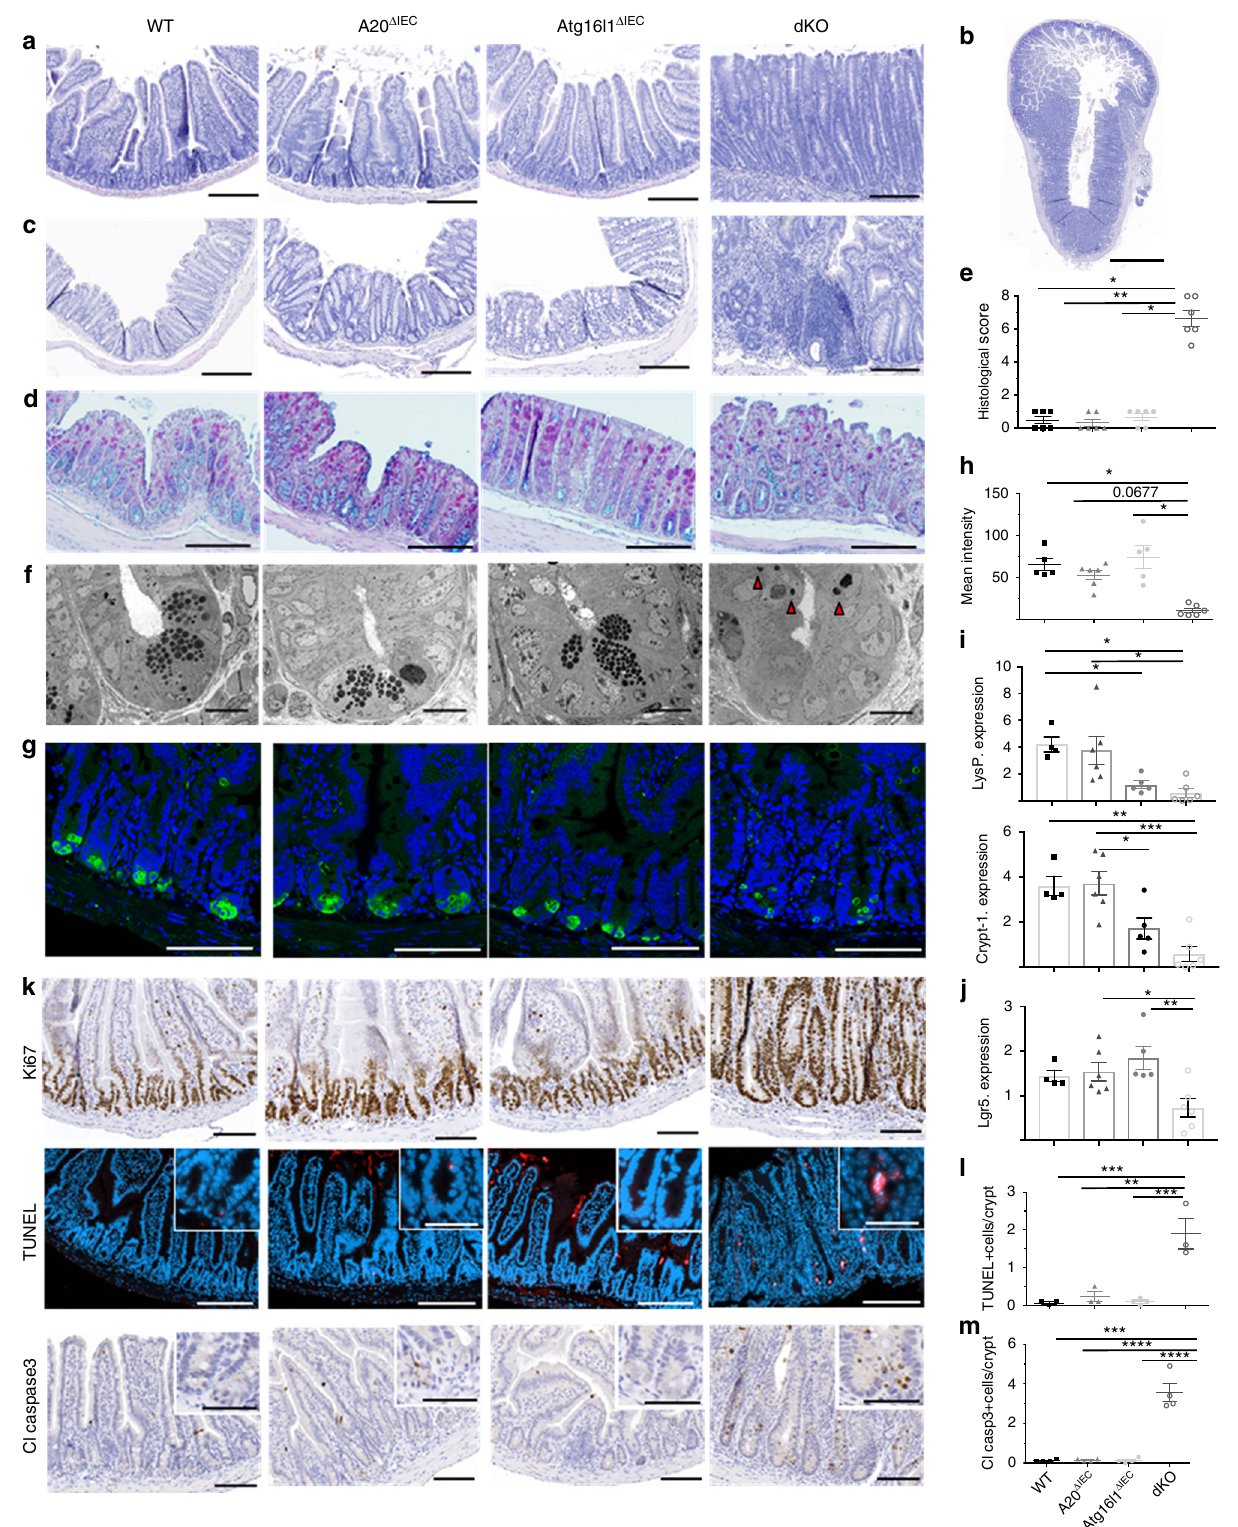
ATG16L1 downregulates A20 through the WDD. Both A20 and ATG16L1 are expressed from constitutive retroviral transgenes in this system, so the observed changes in A20 abundance are likely to be post-transcriptional. Consistently, treatment with lysosomal inhibitors (ba fi lomycin, E64d/pepstatin) tended to normalize A20 expression levels (Supplementary Fig.